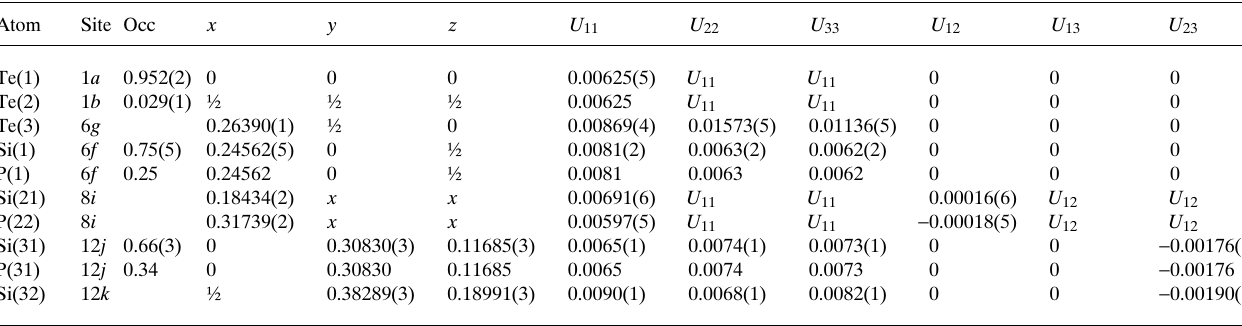
Table 4. Atomic coordinates and displacement parameters (in Å 2 ) .